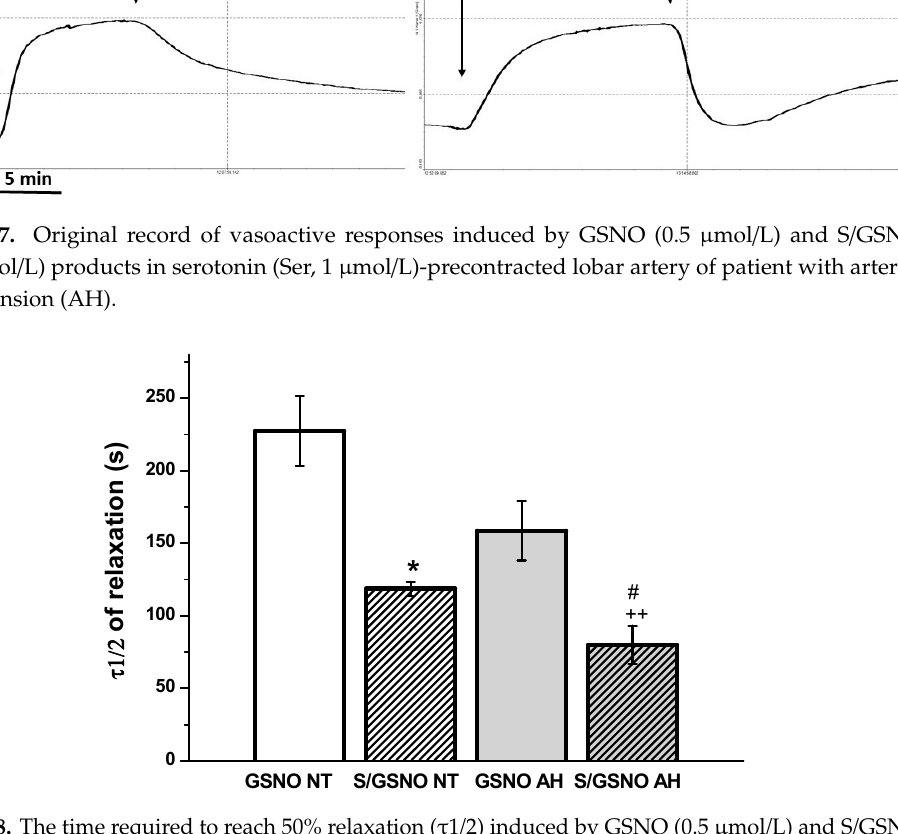
Figure 8. The time required to reach 50% relaxation ( τ 1 / 2) induced by GSNO (0.5 µ mol / L) and S / GSNO (0.5 µ mol / L) products in human lobar arteries of normotensive patients (NT) and patients with arterial hypertension (AH). Values are the mean ± S.E.M. Significant di ff erences were evaluated by one-way ANOVA. Bonferroni post hoc test was used to describe the di ff erences in mean values of the experimental groups. * p < 0.05 with respect to the value of the GSNO NT response, ++ p < 0.01 with respect to the value of the S / GSNO AH response, # p < 0.05 with respect to the value of the S / GSNO NT response.